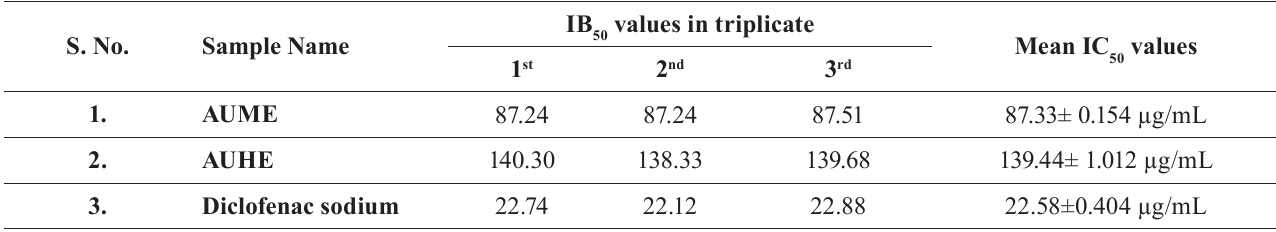
TABLE VII - IB of anti-inflammatory activity of plant extracts of whole plant of A. uliginosa 50